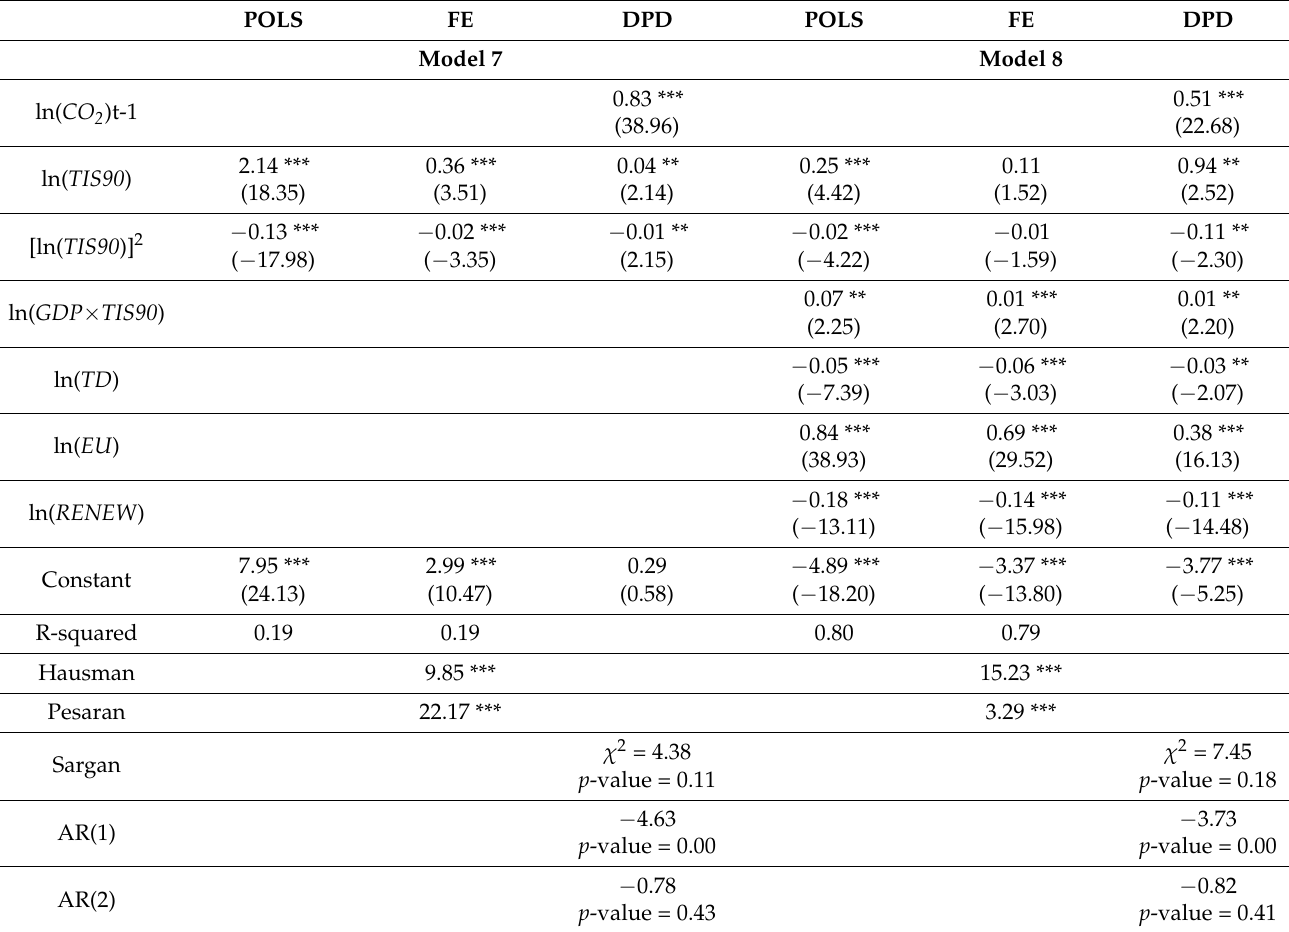
Table 7. The effect of income inequality (measured by top 10% income share) on CO 2